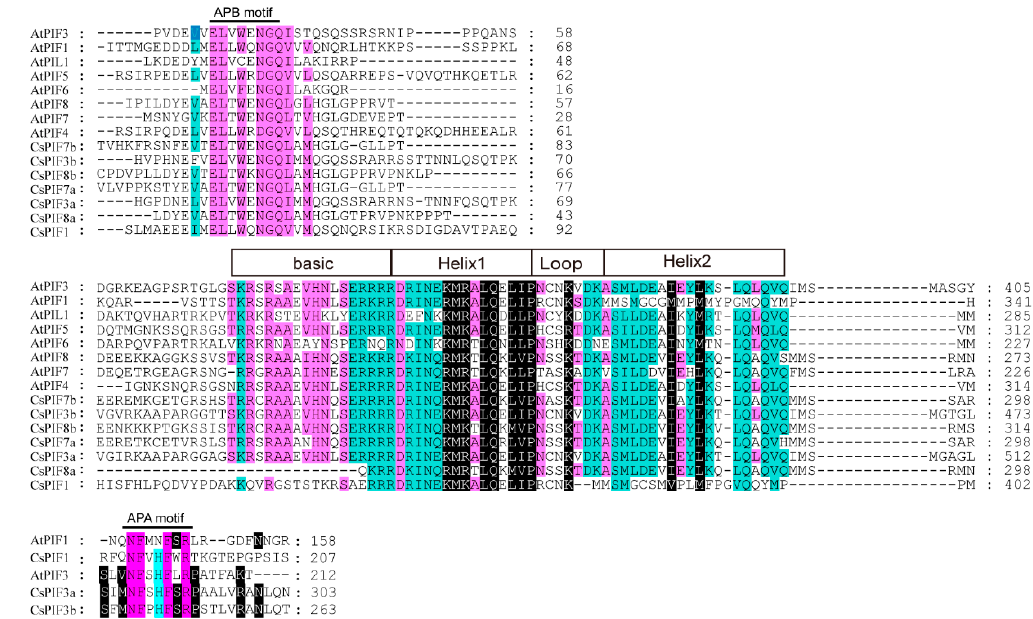
Figure 1. Multiple sequence alignment of PIF proteins in C. sinensis and A. thaliana . Conserved domain is divided into three subdomains (APB, HLH and APA), which are marked with lines above the sequences.